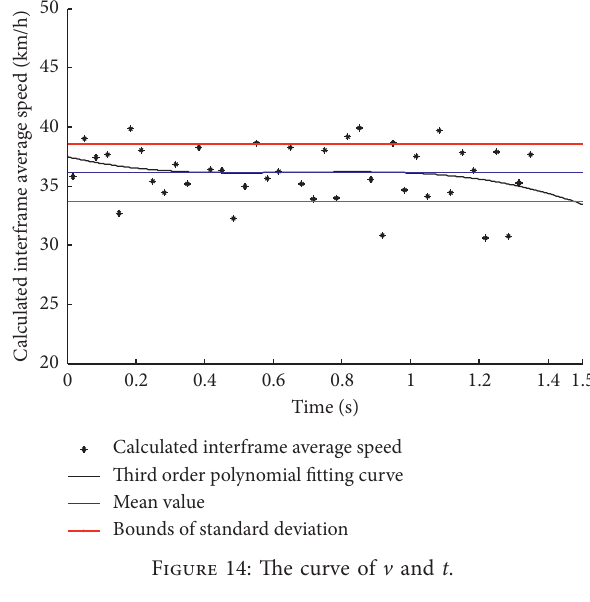
Figure 14: The curve of v and t .